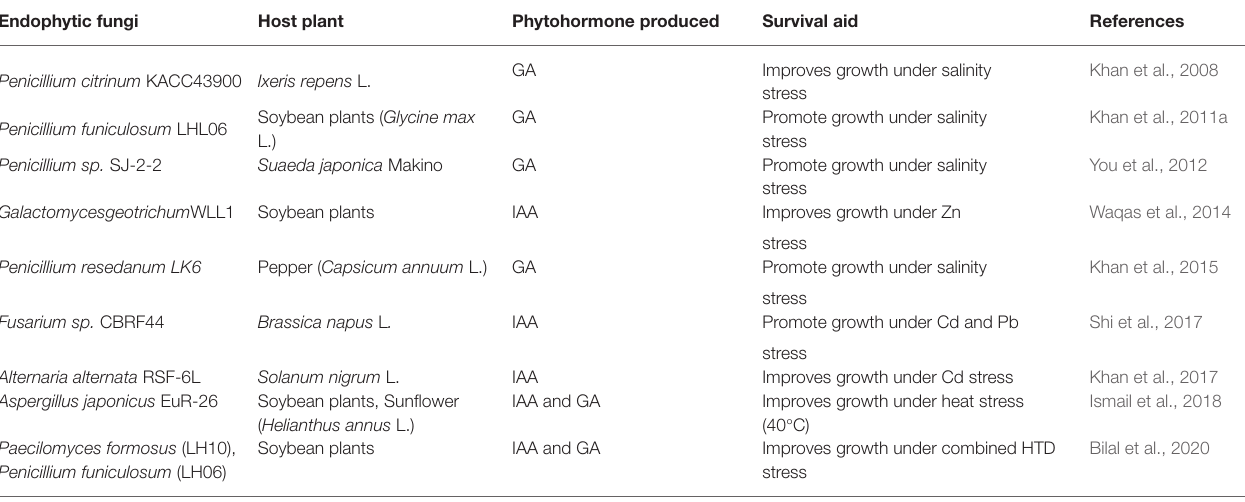
TABLE 5 | Different fungal endophytes that assist in plants’ survival under stress by producing